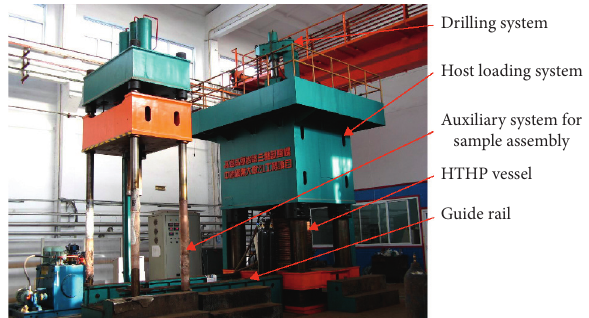
Figure 1: 600 ° C 20 MN servo-controlled triaxial rock mechanics testing machine.